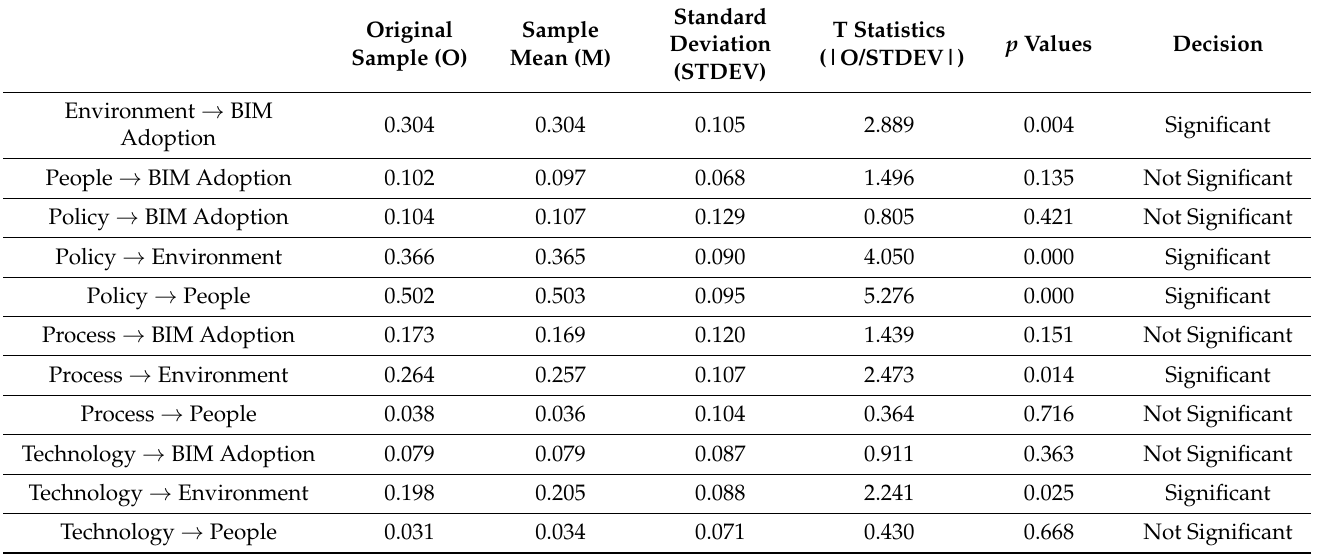
Table 12. Path Coefficient Result.